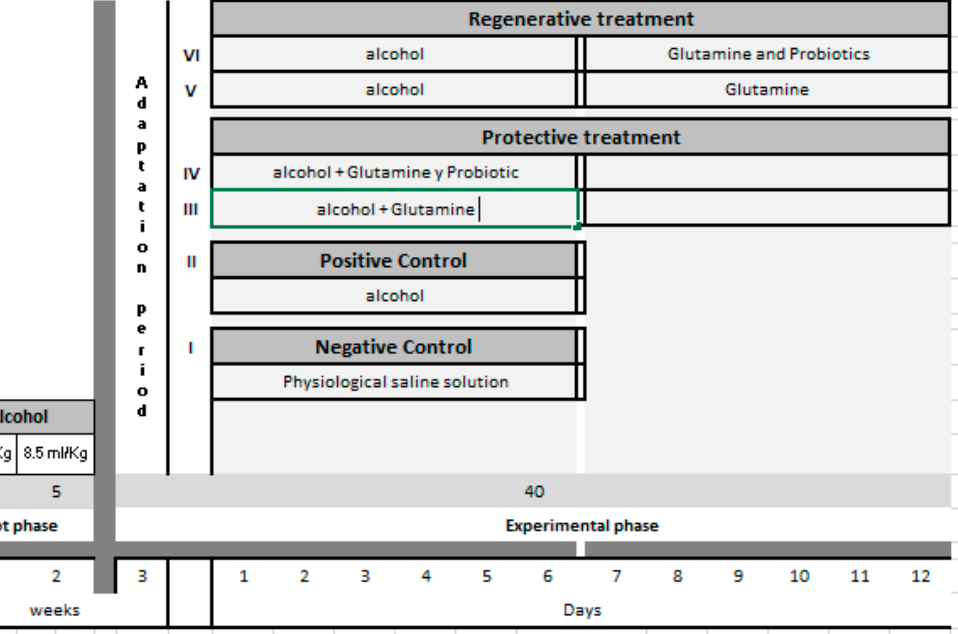
Figure 1. Study design and work scheme. The schematic representation of the periods included in each phase is shown. The pre-pilot phase is considered in weeks and the experimental phase in days. In the pilot phase, the dosages with alcohol to generate the injury were carried out with 10 rats between 7.5 mL/kg (5 rats) and 8.5 mL/kg (5 rats). The experimental phase was carried out with 40 rats separated into 6 groups: negative control, positive control, preventive treatment with gluta- mine (0.5 g of glutamine per kilogram of weight), preventive treatment with glutamine plus probi- otics (0.5 g of glutamine per kilogram of weight and 5 million CFU Lactobacillus reuteri), regenera- tive treatment with glutamine (0.5 g of glutamine per kilogram of weight) and regenerative treat- ment with glutamine plus probiotics (0.5 g of glutamine per kilogram of weight and 5 million CFU Lactobacillus reuteri). The administration was intragastric. 2.4. Pilot Phase The pilot phase was carried out with 10 rats and they were separated into two equal groups with different concentrations. Group A: 7.5 mL/kg of rat weight and Group B: 8.5 mL/kg of rat weight, to determine the dose (7.5 or 8.5 mL/kg) and the number of doses (2, 5, 8 or 12) that generate the gastric damage caused by alcohol. The time it lasted was two weeks. Histological evidence of gastric dysplasia was observed at a histological level after the different doses of alcohol were ingested through a cannula by each one of the rats. The pilot phase lasted two weeks, with each animal receiving its established dose daily. It was determined that the dose of 8.5 mL/kg generated the greatest gastric damage in the pilot phase. Thus, we were able to establish the dose that would induce ethanol injury to be used in the experimental phase, which was offered without fasting and given to the ex- perimental animals in their diet to simulate normal feeding. 2.5. Experimental Phase Glutamine and glutamine plus probiotics were calculated according to the initial weight of the Holtzman rats, and each dose of glutamine or glutamine plus probiotics was 0.5 g/kg per rat. The experimental phase lasted 12 days. Forty rats were selected in 6 groups and were distributed as follows: Group I, negative control (Healthy); Group II, positive control (Damage); Group III, protective treatment with glutamine, which re- ceived a diet plus glutamine supplementation (0.5 g/Kg); Group IV, preventive treatment with glutamine and probiotics (0.5 g/Kg + 5 million CFU Lactobacillus reuteri ); Group V,